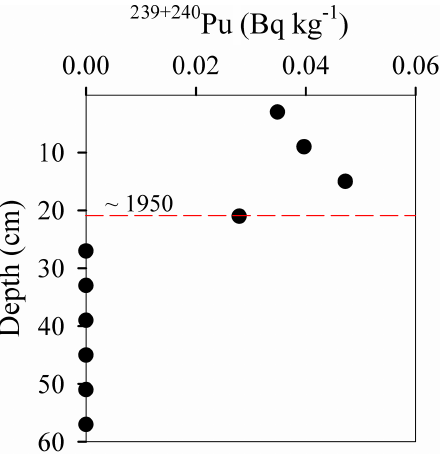
Figure 3. 239 + 240 Pu profile, indicating that ∼ 1950 is when these radionuclides were first introduced into the atmosphere.